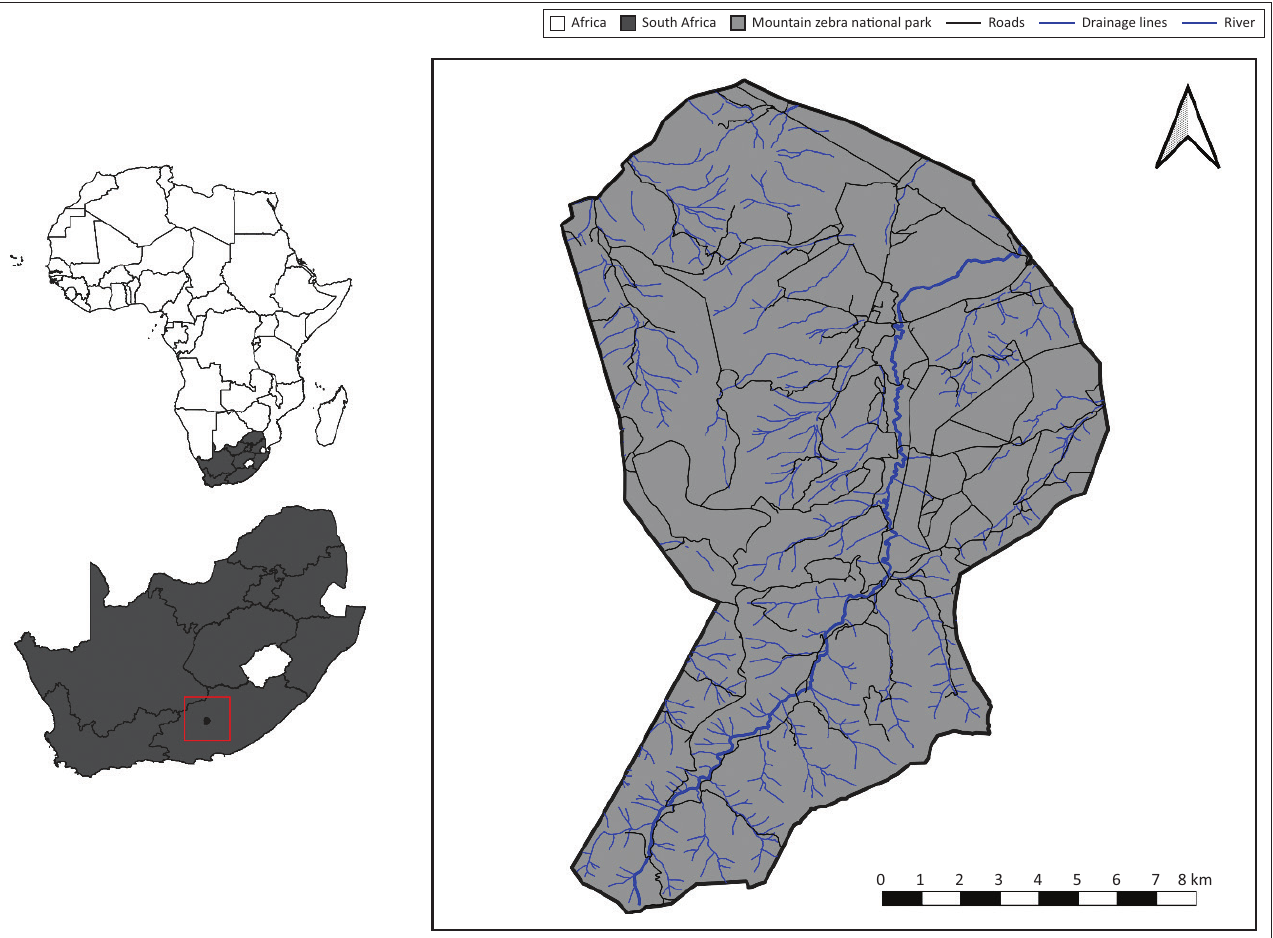
FIGURE 1 : The current (2020) extent of the Mountain Zebra National Park in the Eastern Cape, South